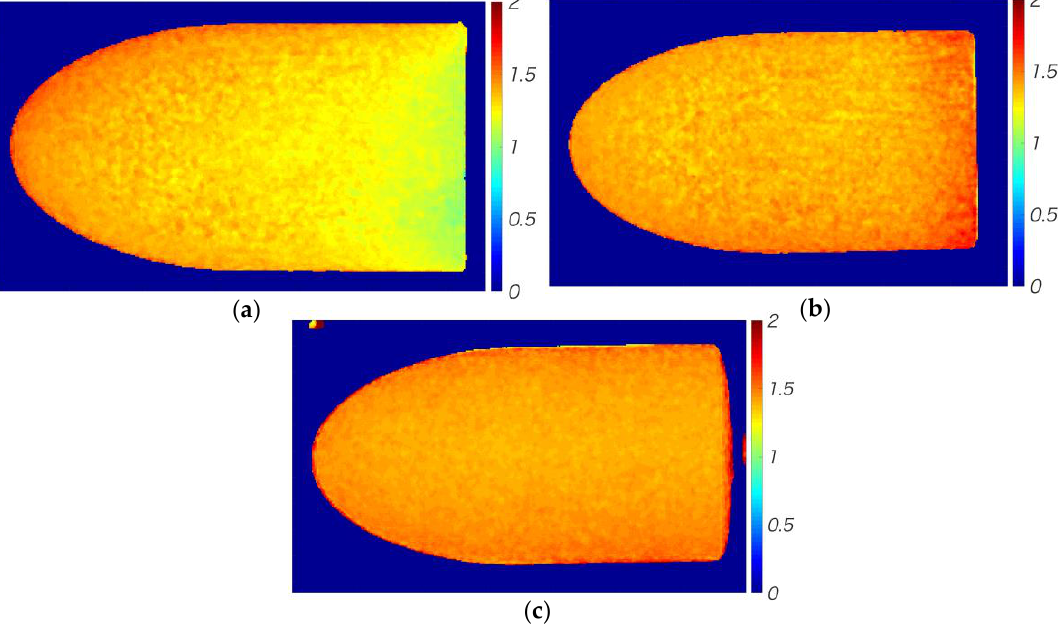
Figure 6. Luminescence ratio distributions on the test models. ( a ) Static dipping; ( b ) Convectional dipping; ( c ) Rotational dipping.